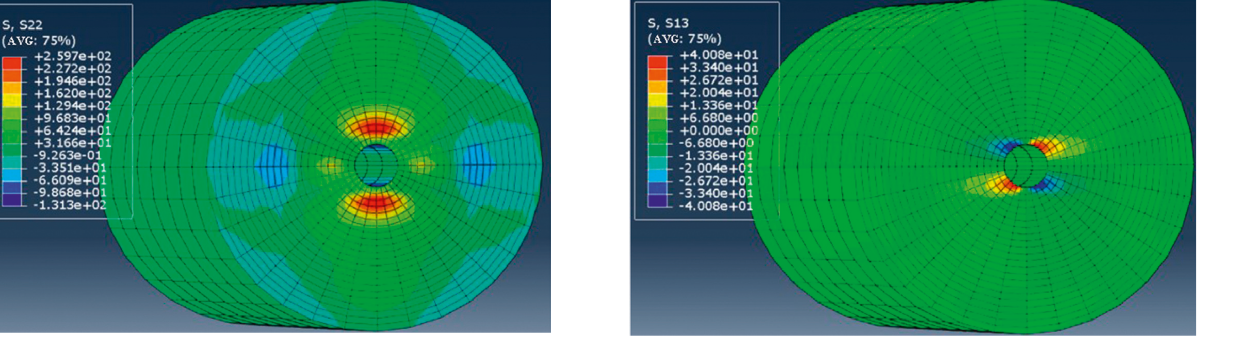
Figure 28: Stress cloud of middle layer S13 in 400% compression shear condition.